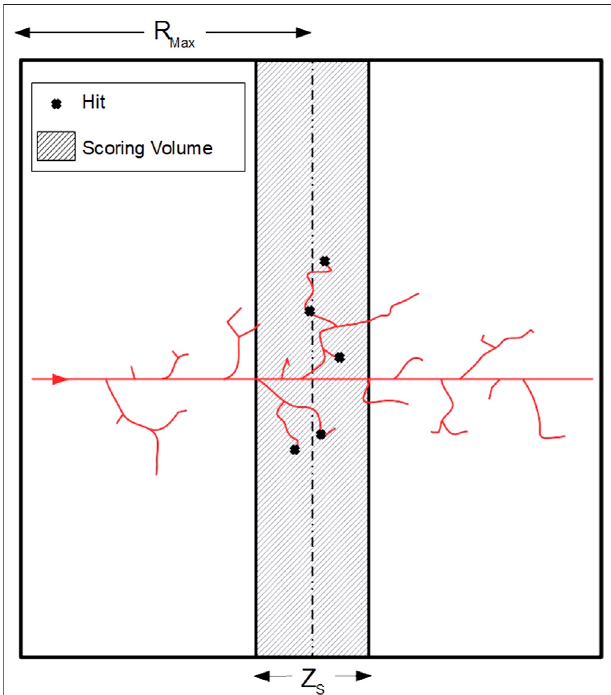
FIGURE 1 | Scheme of the geometry used for microdosimetry simulations (2D projection). The primary proton (red track) is generated at the surface (on the left) of a cubic water volume (world volume) and travels along the Z axis. The energy transfer points (hits) are then scored in the middle of the volume (shaded area), in a slab whose thickness ( Z S ) varies depending on the dimension of the site. The spherical sites are not physically simulated, as they are virtually selected in the scoring volume with an algorithm that dependsonthetypeofrandomnessconsidered.Finally, thehalf-dimensionof the world volume ( R max ) varies according to the maximum energy of the incident protons, and is slightly greater than the maximum range of the δ -rays